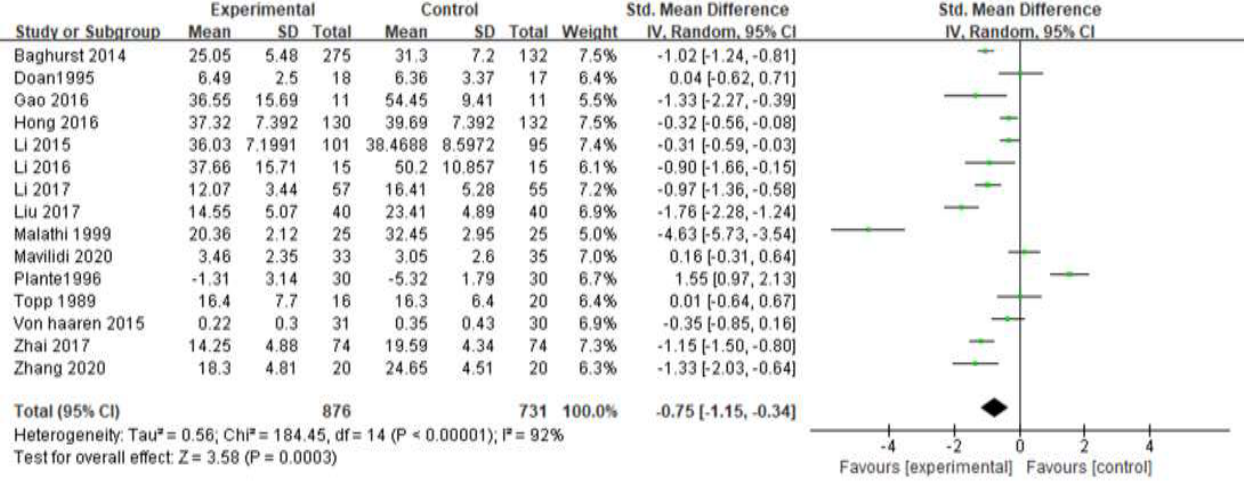
Figure 3. Forest plot of the effect of exercise intervention on test anxiety [17–20,22–32]. The data in Figure 3 show high heterogeneity (I 2 = 92% > 50%). Therefore, sensitivity